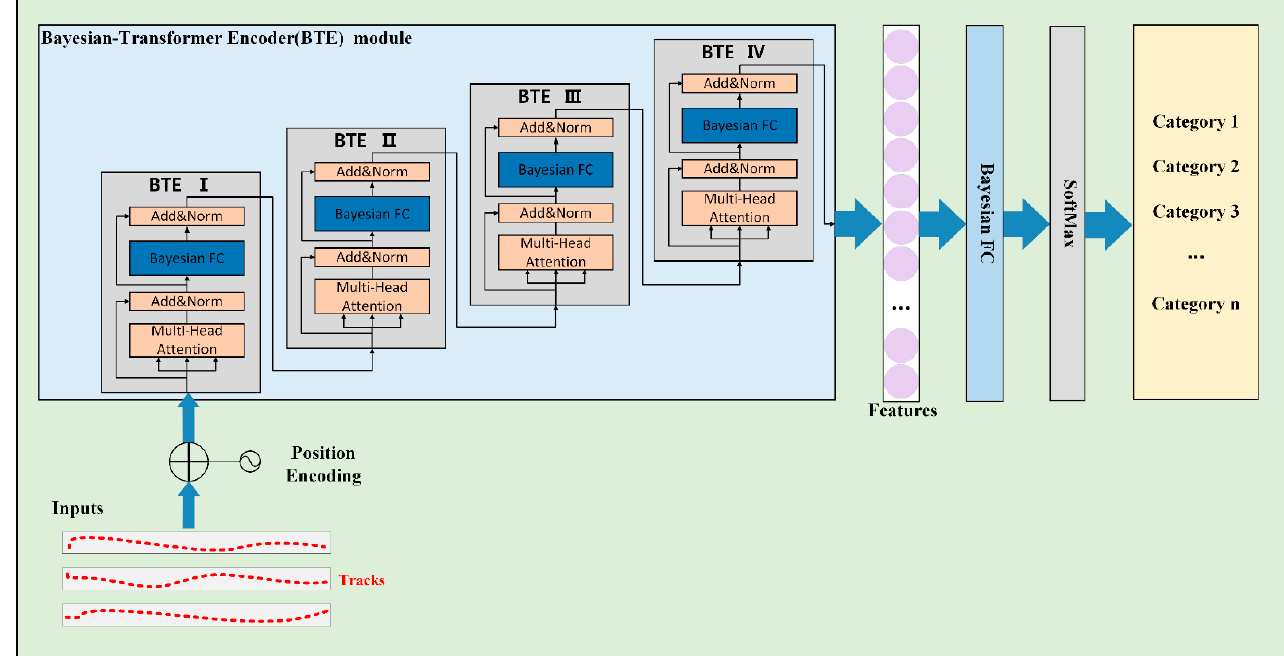
Figure 1. The structure of the BTNN.